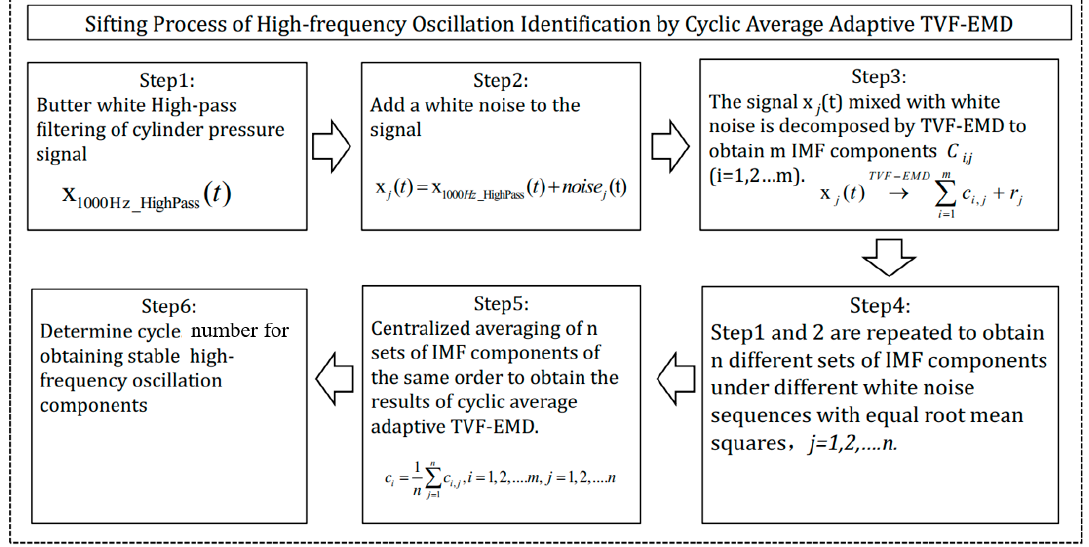
Figure 8. The process of the cyclic average time varying filter based empirical mode decomposition (TVF-EMD) method.